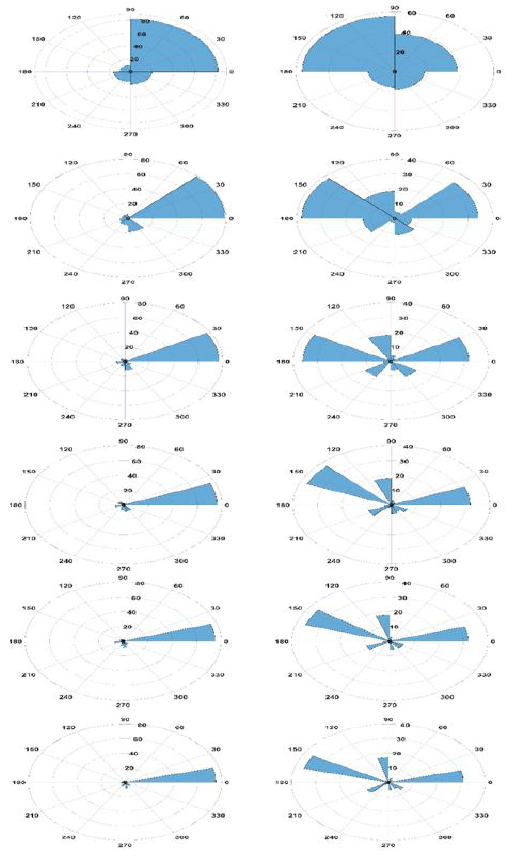
Fig. 3. Upper charts are for x projections while lower charts are for y-projections with the order from left to right (4,8,12,16,20,24) bin